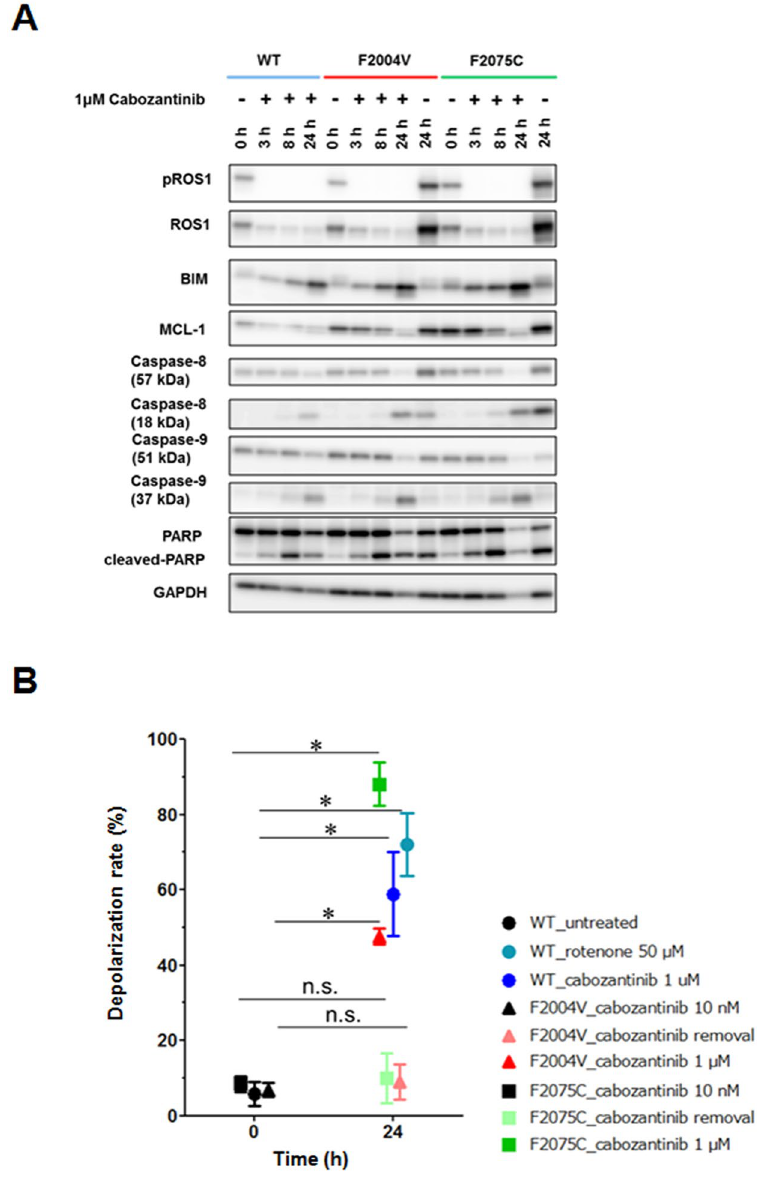
Figure 3. Distinct apoptosis mechanisms with cabozantinib removal and with high-dose cabozantinib treatment. ( A ) Immunoblotting for wild-type CD74-ROS1, F2004V-, or F2075C-mutated cells with or without treatment with 1 μ M cabozantinib. Cell lysates were immunoblotted to detect the indicated proteins. ( B ) Mitochondrial depolarization assay by flow cytometry was performed for wild-type CD74-ROS1 cell (treated with 50 μ M rotenone or 1 μ M cabozantinib), F2004V- or F2075C-mutated cells (with or without 1 μ M cabozantib). Rotenone, a mitochondrial electron transport system inhibitor, was used to treat wild-type CD74- ROS1 cells as a positive control. Each value is shown as mean ± SD of three independent experiments. Statistical significance was calculated by a t test; * indicates p < 0.05 and n.s., p ≥ 0.05. Uncropped blots are presented in Supplementary Fig.